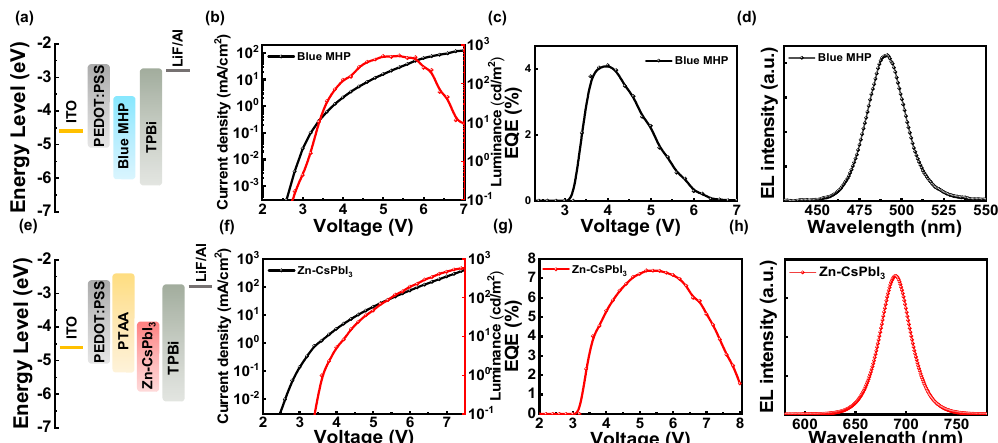
Figure 2. ( a , e ) Energy level diagrams of blue and red PeLEDs. MHP: metal halide perovskite. ( b ) and ( f ) Current density and luminance versus voltage plots of blue and red PeLEDs. ( c , g ) EQE versus voltage plots of blue and red PeLEDs. ( d , h ) EL spectra of blue and red PeLEDs. The orthogonality of the solvent needs to be considered in the preparation of the tandem device, and the light-emitting direction needs to avoid going from the blue-emitting layer to the red-emitting layer, which would result in a part of the blue light energy